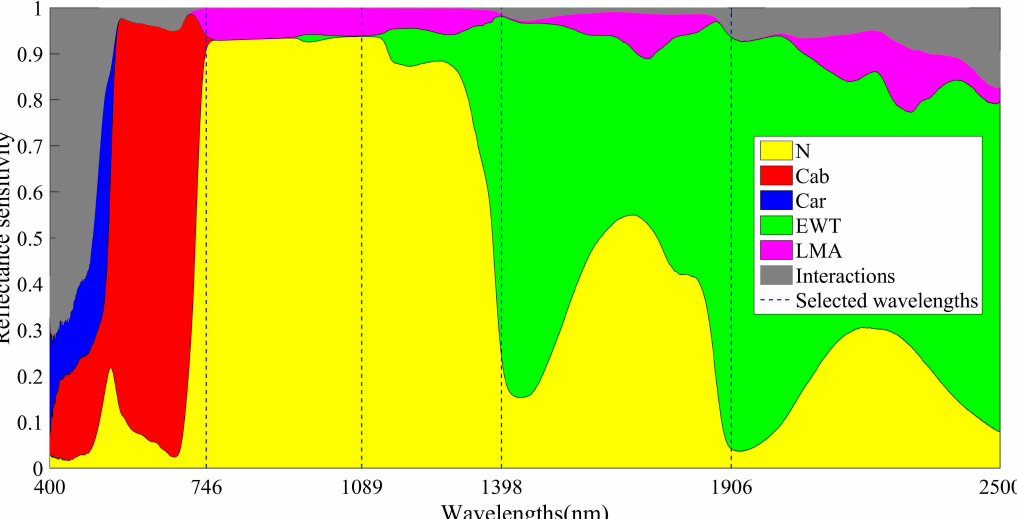
Figure 2. Position of selected wavelengths of N and EWT in the sensitivity analysis for PROSPECT model for reflectance (N: structure index, Cab: chlorophyll, Car: carotenoid, EWT: equivalent water thickness, LMA: dry matter per area, Interactions: joint global sensitivity for different combinations of parameters).